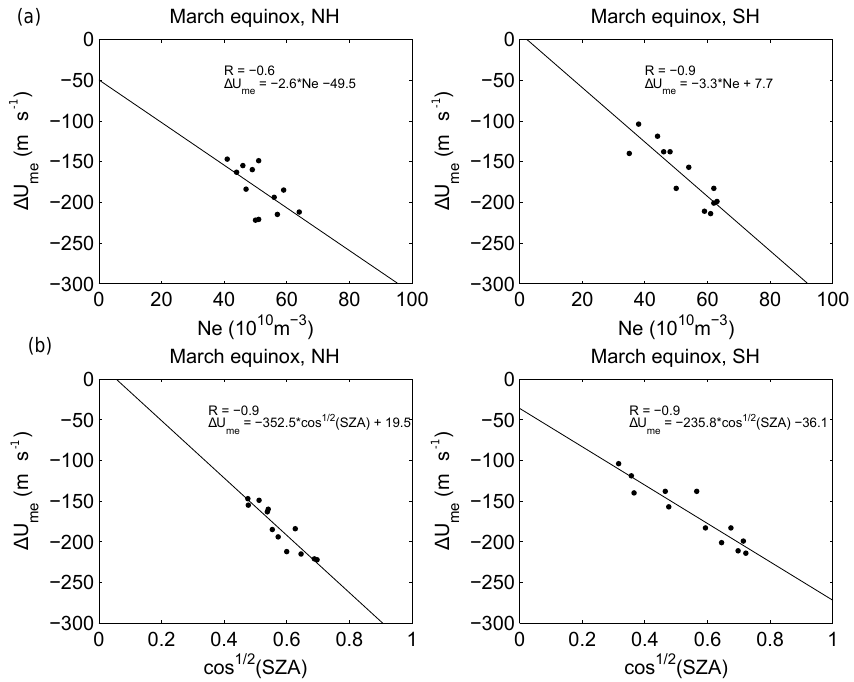
Figure 6. The top row shows the correlation between the strongest westward disturbance neutral wind with peak electron density in both hemispheres. The bottom row shows the correlation between the strongest westward disturbance neutral wind with cos 1 / 2 (SZA) (solar zenith angle, SZA) in both hemispheres. The correlation coefficient ( R ) and linear relationship between the parameters are shown in each